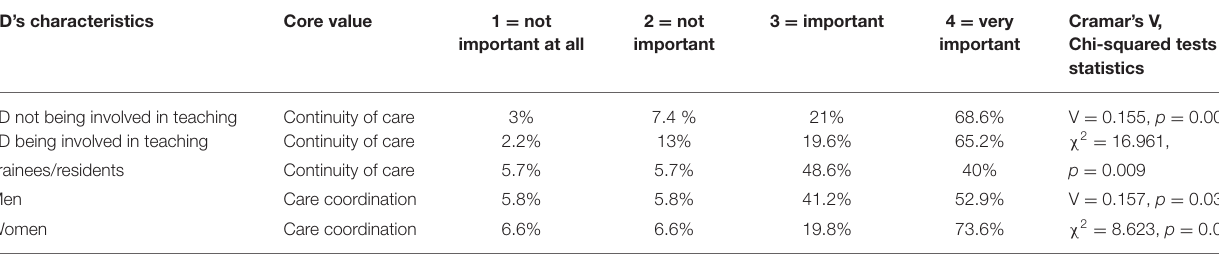
TABLE 5 | Cramer’s V and Chi-squared associations between the FDs characteristics and their ranking of CV. FD’s